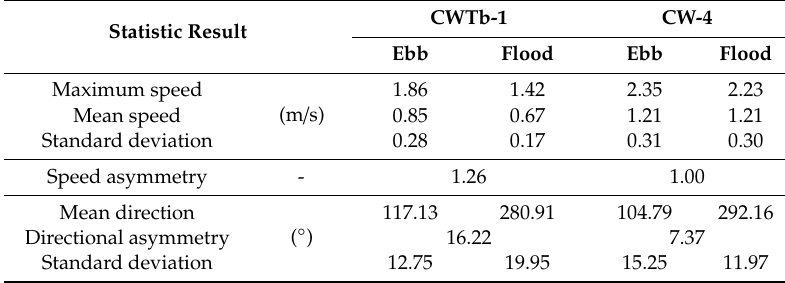
Table 4. Summary of statistic results of current speed measured with instruments CWTb1 and CW4.